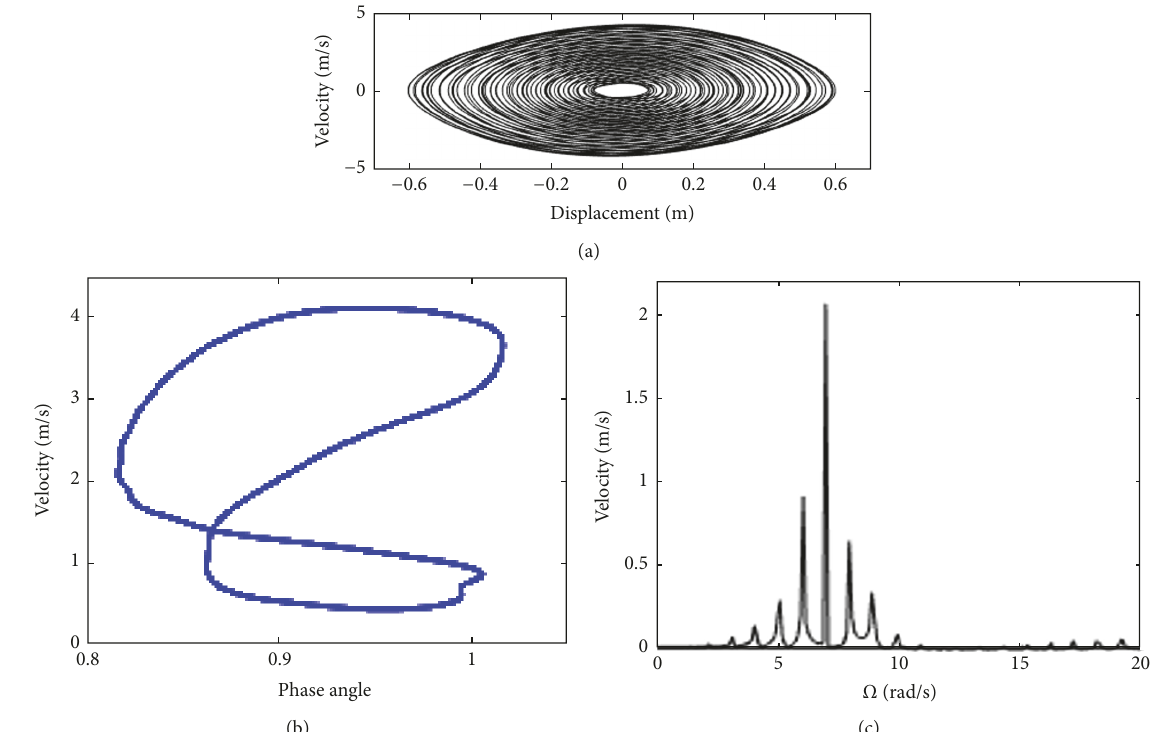
Figure 11: Quasiperiodic orbit at Ω = 8.0 rad/s: (a) the phase portrait, (b) the Poincar´e map, and (c) the frequency spectrum.